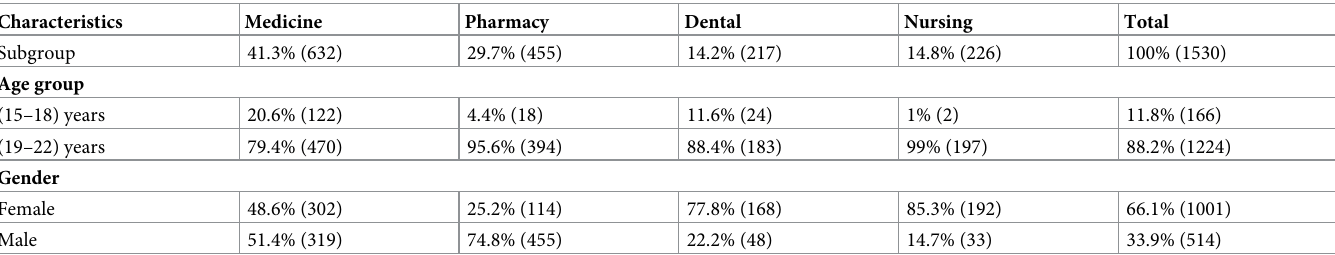
Table 1. Sample profile: Socio-demographic distribution % (n) of participants in each health professional sub-group.